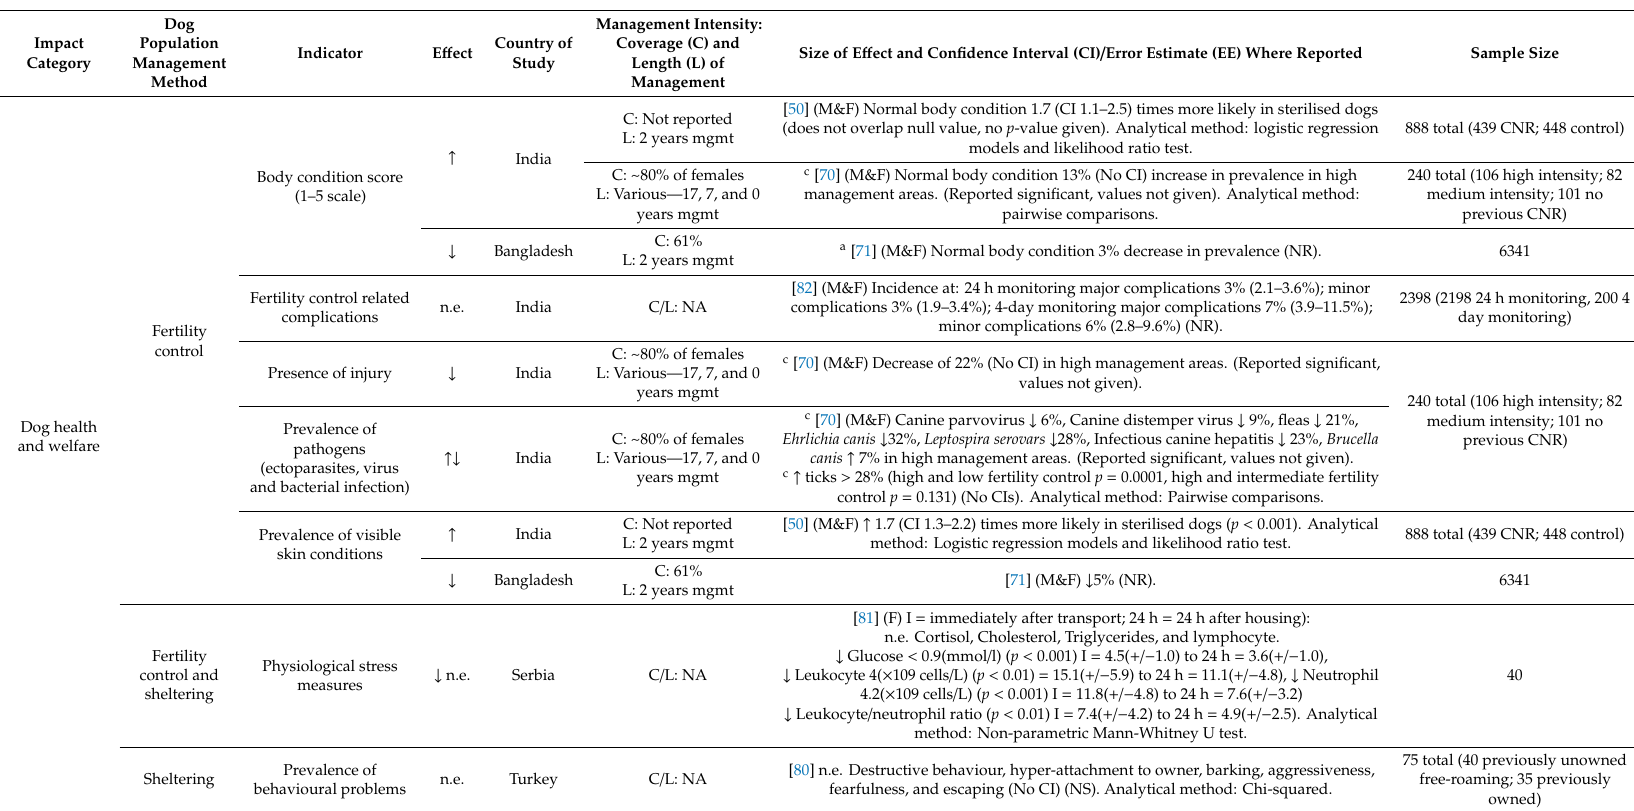
Table 3. Results from papers in the final corpus (excluding modelling studies) of the effects of methods of dog population management on the indicators of impact and impact categories. ↑ indicates an increasing effect, ↓ a decreasing effect and n.e. no effect; combinations of different symbols indicate where evidence is conflicting. Where p -values were reported, this is included (e.g., p < 0.05), NR = p -value was not reported, NS = p -value not significant. NA = not applicable for the study design. The size of effect is extracted from papers and reported in terms of the years of: (i) mgmt. = management (indicating the study and management method took place at the same time) or (ii) study (indicating the study took place after management began). Where fertility control is included in the dog population management method, (M&F) indicates fertility control was applied to both males and females, (F) indicates only female fertility was controlled. Supporting evidence is provided in